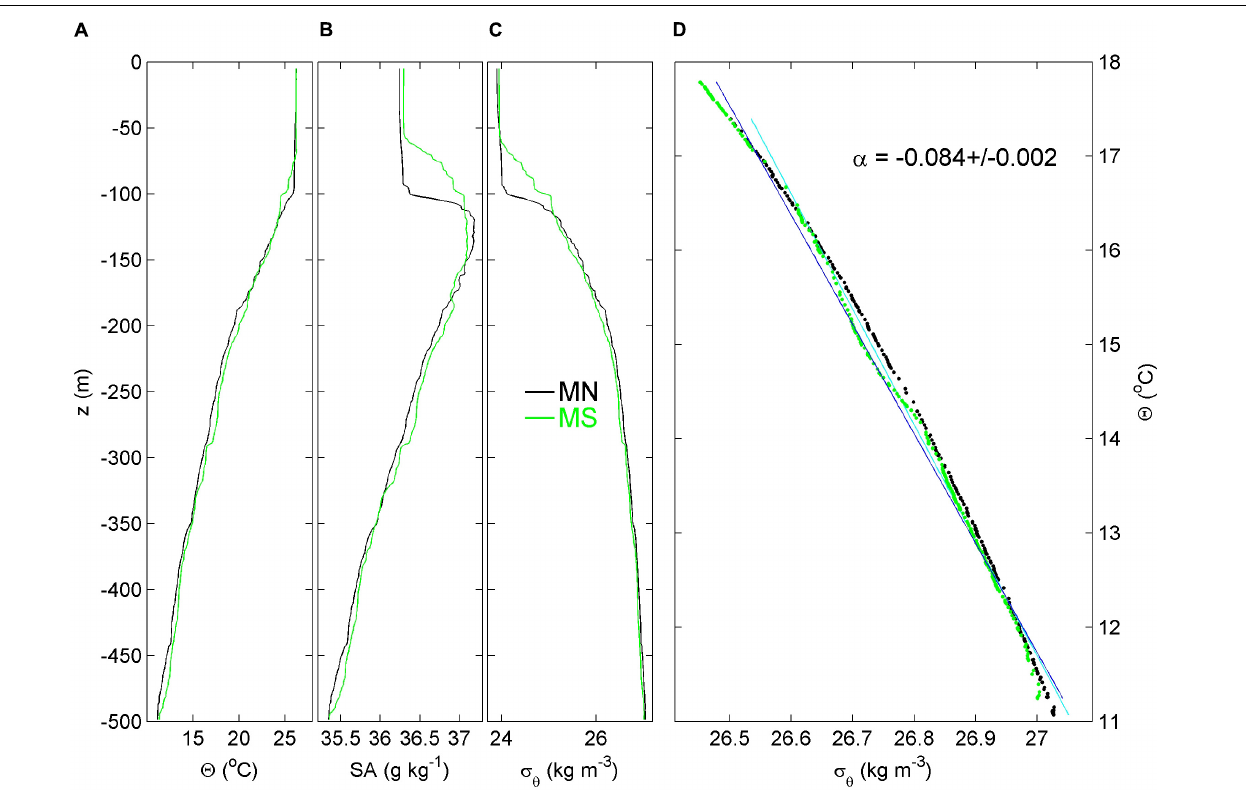
FIGURE 4 | CTD-profiles to within 1 km from MN (black) and MS (green). (A) Conservative ( ∼ potential) Temperature. (B) Absolute Salinity. (C) Density anomaly referenced to the surface. (D) Conservative Temperature-density anomaly relationship, from the CTD-data between 250 and 500 m, with mean linear fit indicated in